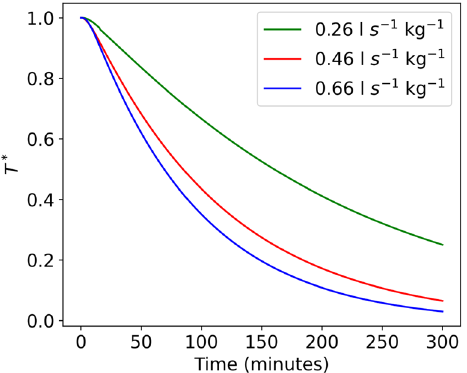
Figure 10. Influence of the airflow rate on the cooling kinetics of the products (crate B).